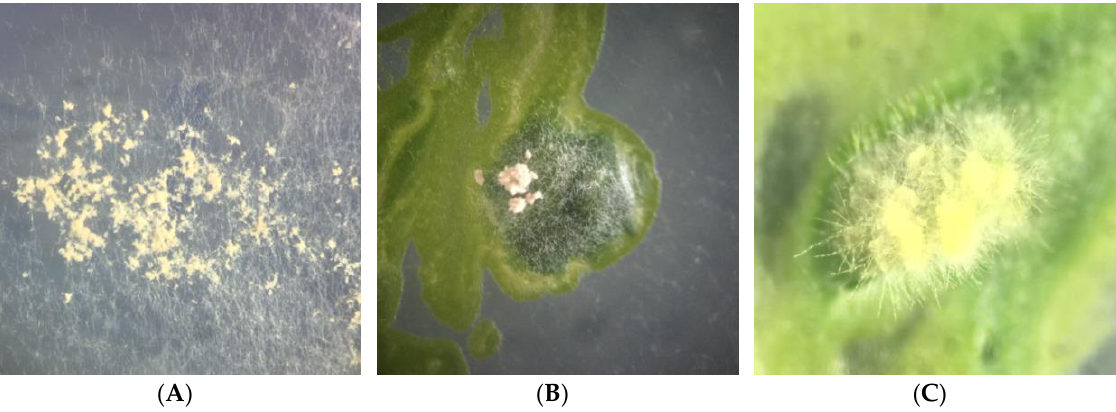
Figure 8. Re-synthesis evaluation in vitro: ( A ). Xylaria spp. mycelia growing without photobionte. ( B ). Contact of mycelium with Trebouxiaceae biomass. ( C ). Close-up showing an interaction with fungi mycelia and algae cultures.